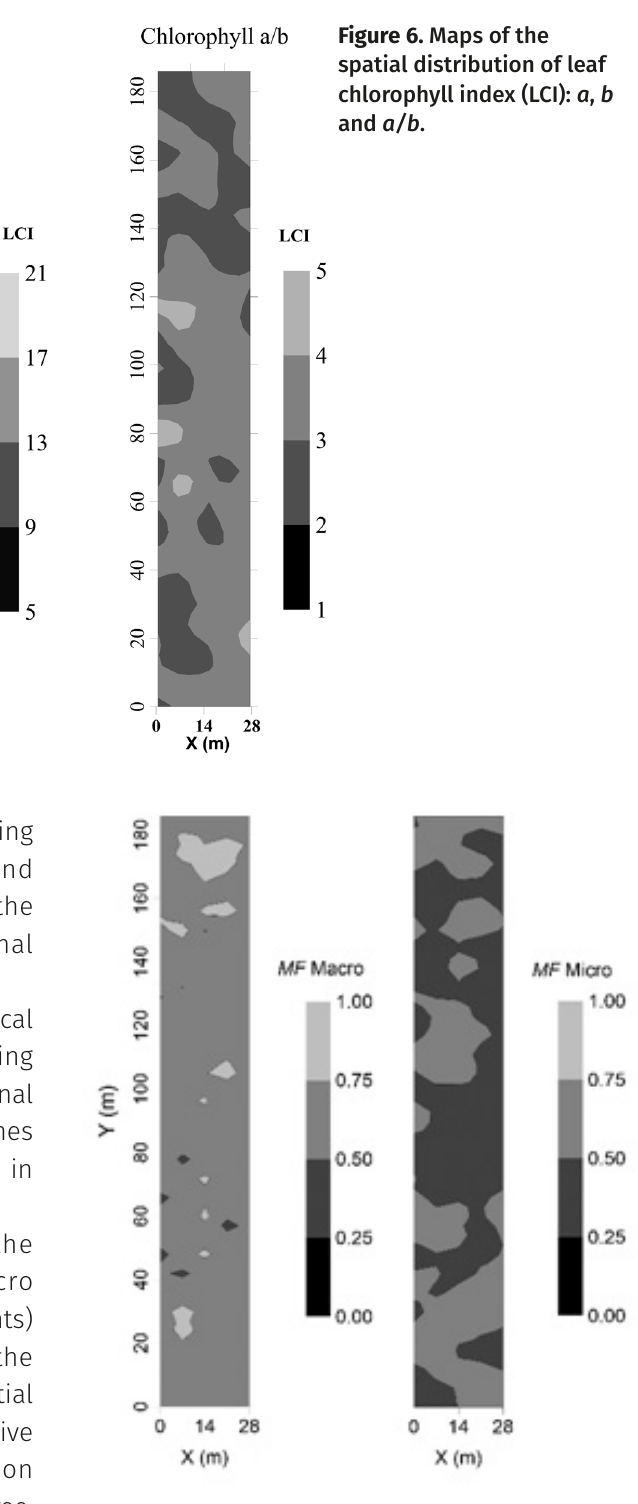
Figure 7. Maps of the spatial distribution of the fuzzy index (FI), after fuzzy classification, for macronutrients (AM Macro) and leaf micronutrients (AM